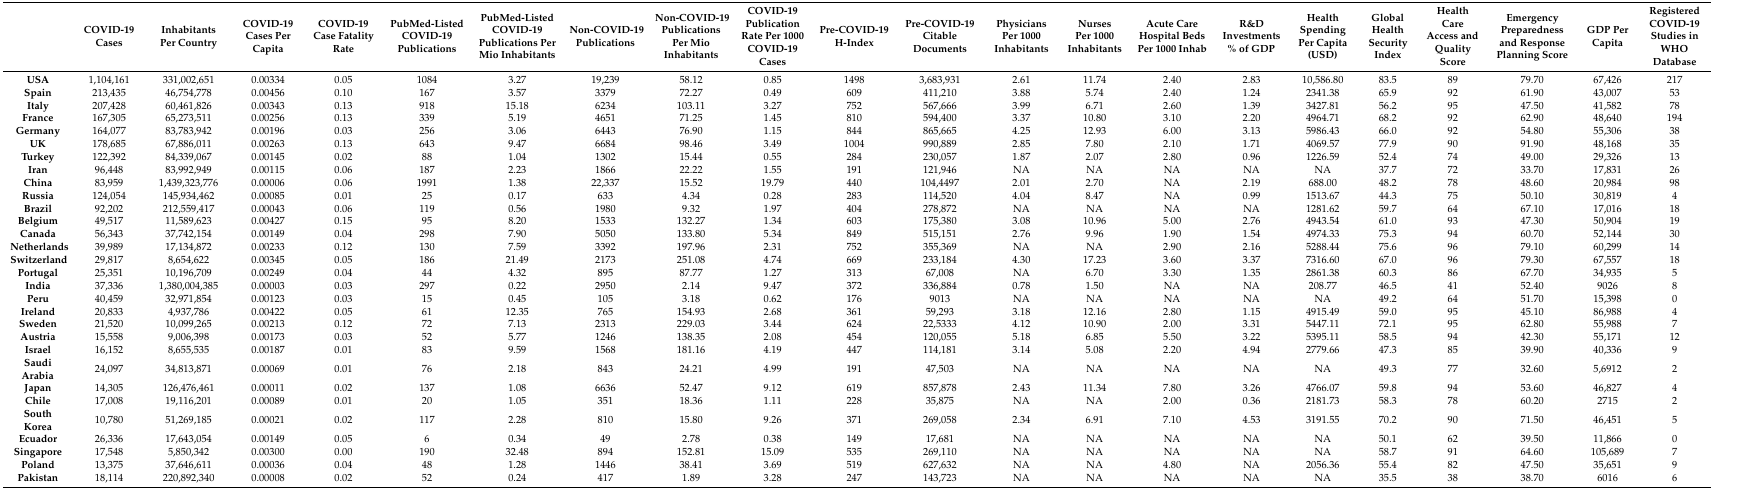
Table 2. Overview of the 30 countries most a ff ected by COVID-19 by the end of April 2020. For each country, the COVID-19 publications and non-COVID-19 publications between January 1 and April 30 2020 are listed, including the factors